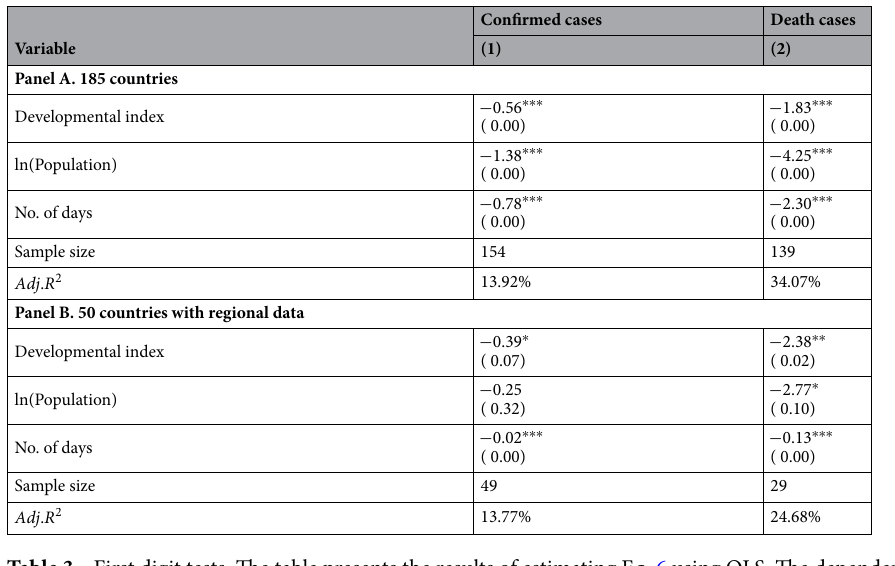
Table 3. First digit tests. The table presents the results of estimating Eq. 6 using OLS. The dependent variable is the D goodness-of-fit measure for first digits. The unit of observation is a country. Panel A shows the results for the whole dataset with 185 countries for the cumulative number of confirmed cases and death cases; panel B shows the results for 50 countries with regional data. To avoid small coefficients, we divide the development index and ln(Population) by 100 and No. of Days by 1000 for all models. Sample sizes vary due to missing values. P -values for a one-tailed t -test are in parentheses. ***, **, and * denote significance at the 1%, 5% and 10% levels,